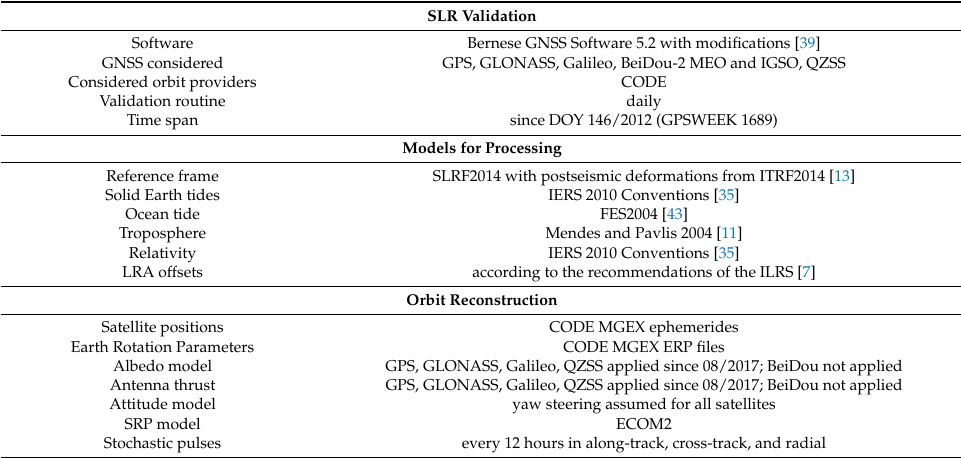
Table 1. Summary of observation modeling and parameter estimation